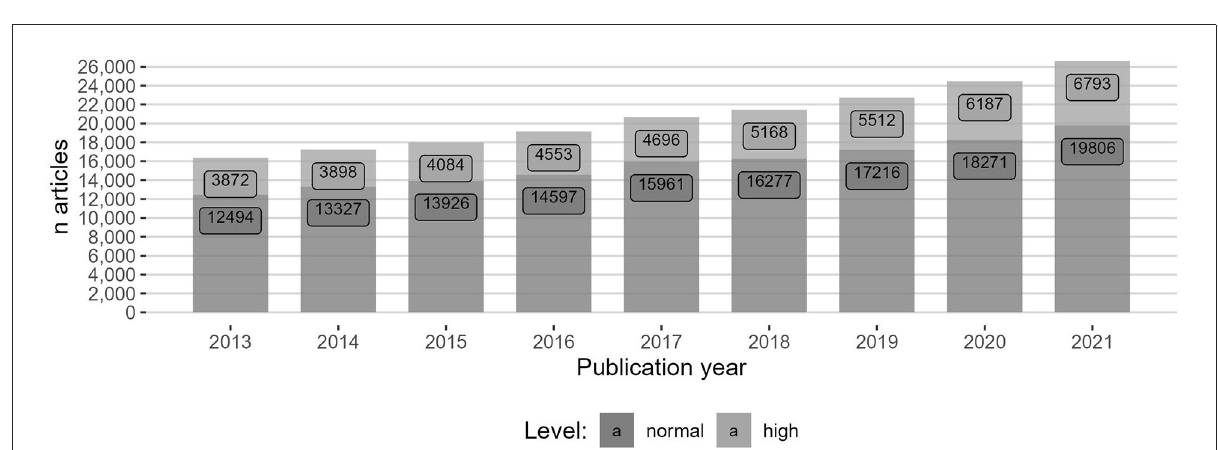
FIGURE1 Absolute growth in Norwegian journal articles in the period 2013–2021, including their distribution between level normal and level high according to the Norwegian journal ranking.